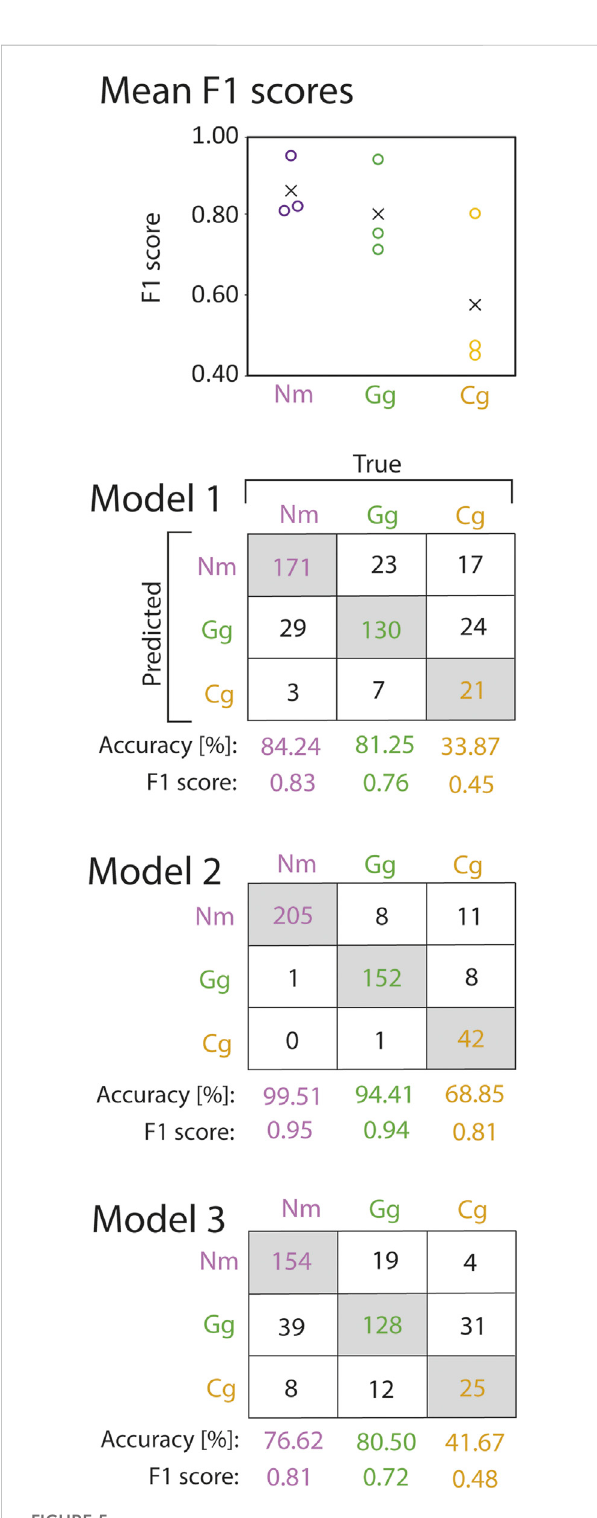
FIGURE 5 F1 scores (circles) and mean F1 scores across all cross validation models(crosses)ofroundgoby(Nm),gudgeon(Gg),andbullhead(Cg) species prediction from the random forest cross validation (top). Corresponding confusion matrices are provided below. Numbers in the grey shaded boxes represent the number of correctly predicted trajectories for the corresponding fi sh species. Numbers in white boxes represent false